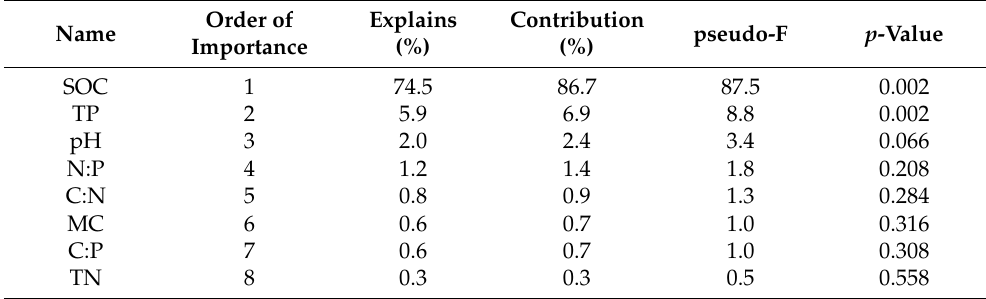
Figure 6. Two-dimensional sequence diagram of RDA analysis of soil enzyme activities and envi- ronmental factors. mental factors. Table 2. Importance ranking in the interpretation of soil environmental factor variables and signifi- cance